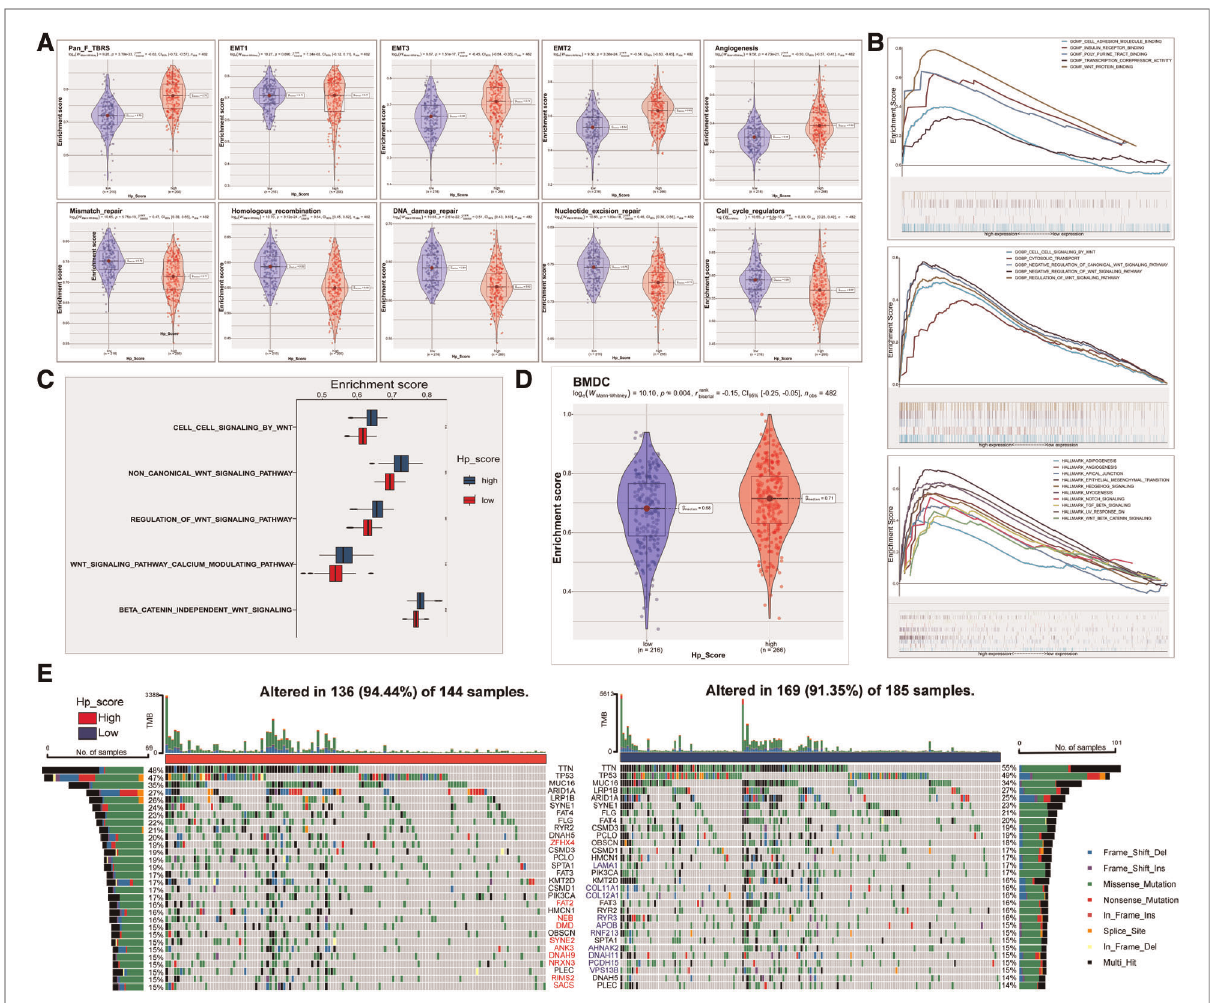
FIGURE 7 Clinical features and tumor stemness signature of HPscore. ( A ) Boxplot for the signi fi cant differences of the current immune-related signatures between two HP_score groups. ( B ) Prediction of HPscore-related pathways and molecular function by enrichment plots from GO analysis and hallmark enrichment pathway. ( C ) Differences enrichment scores of Wnt pathway between two HP_score groups. ( D ) Boxplot for the signi fi cant differences of BMDC enrichment scores between the two HP_score groups. ( E ) The landscape of tumor somatic mutation between the two HP_score